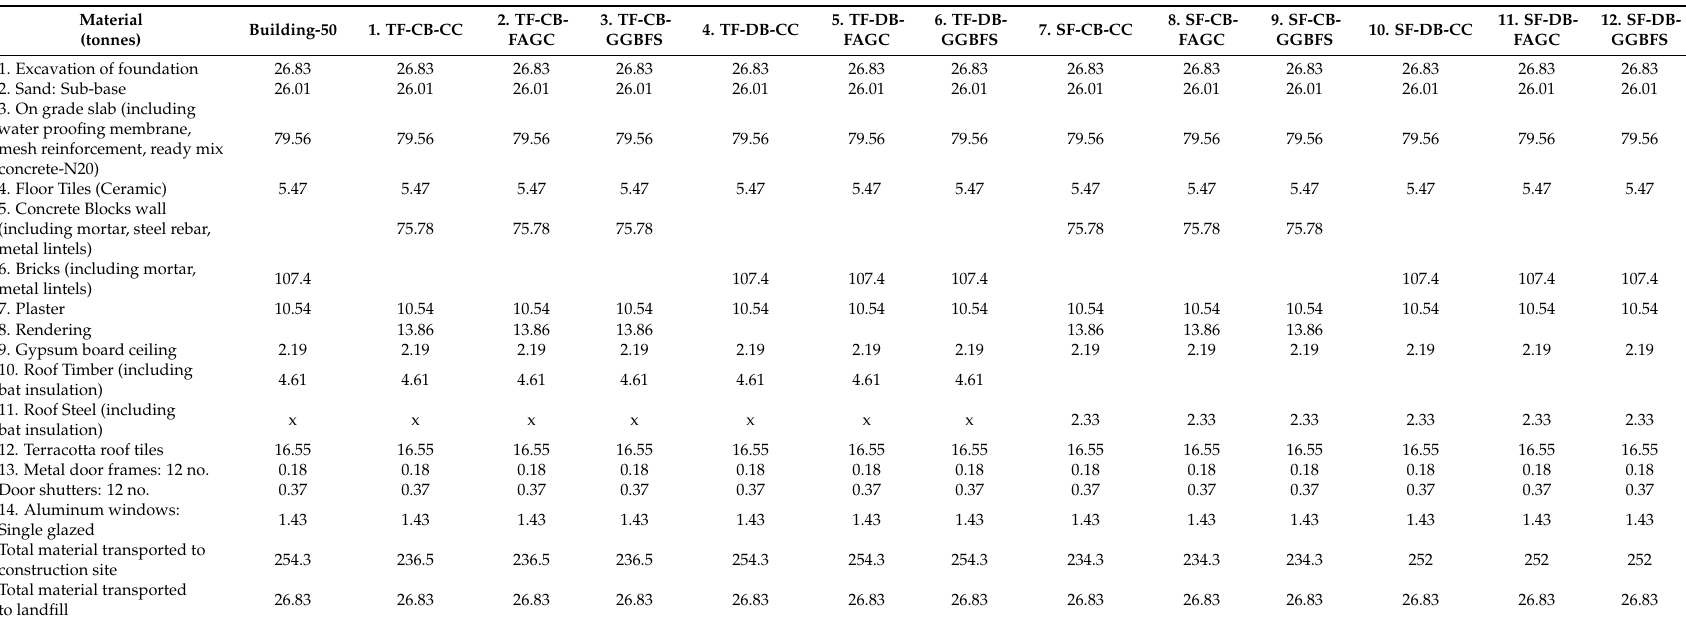
Table A1. Life cycle inventory of materials for the construction stage of case study